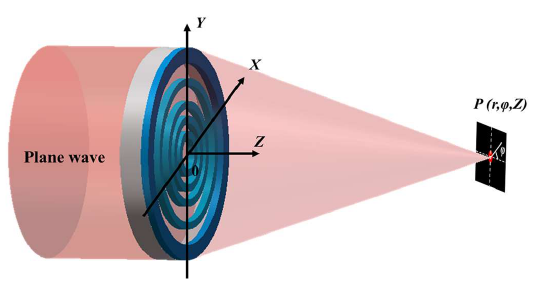
Figure 2. Schematic illustration of sub-diffraction-limit focusing by a planar super-oscillatory lens (SOLs).